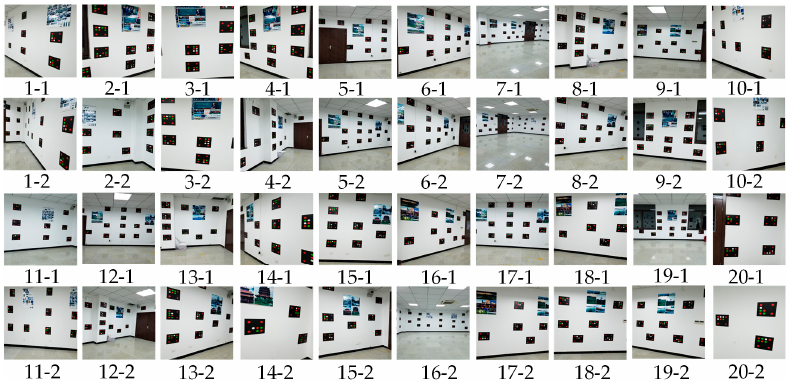
Figure 12. Images of Samsung Galaxy S8 smartphone. Table 1. Positioning accuracy of the Samsung Galaxy S8 smartphone.